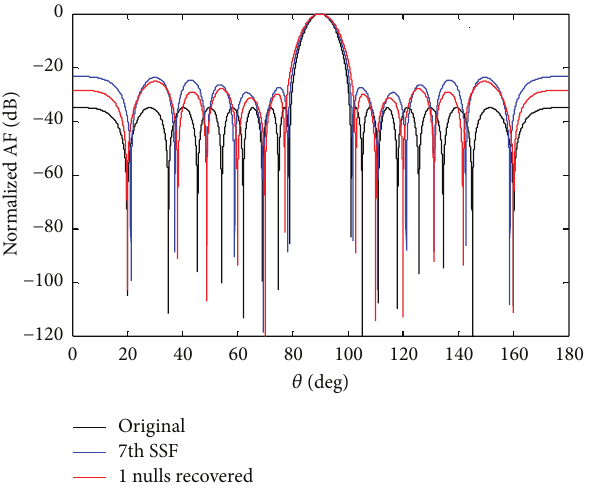
Figure 7: The original radiation pattern, the 𝑤 7 SSF, and recovery of two